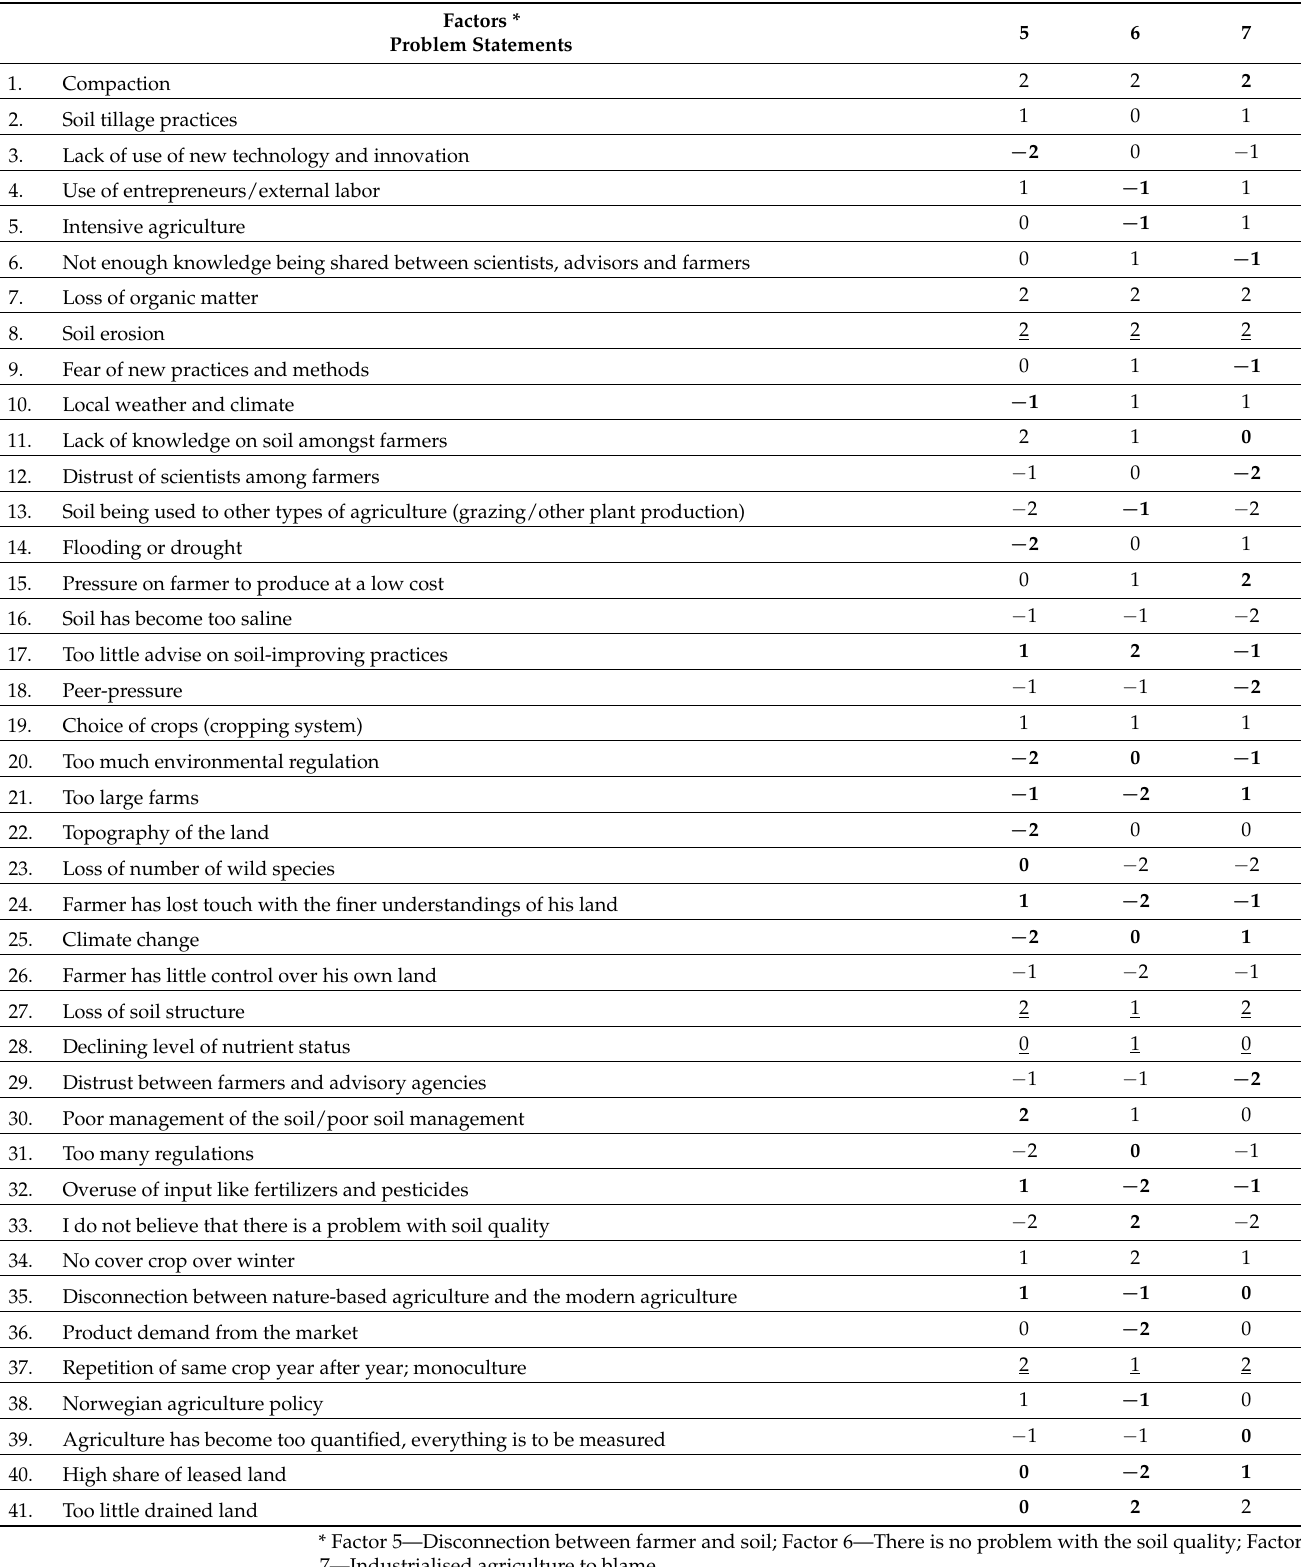
Table A2. Average Q-sort scores for each of the four factors identified as causing problems by Norwegian respondents. Bold text indicates distinguishing statement at p < 0.01, underlined text indicates consensus statements; scale from − 2 (strongly disagree) to 2 (strongly